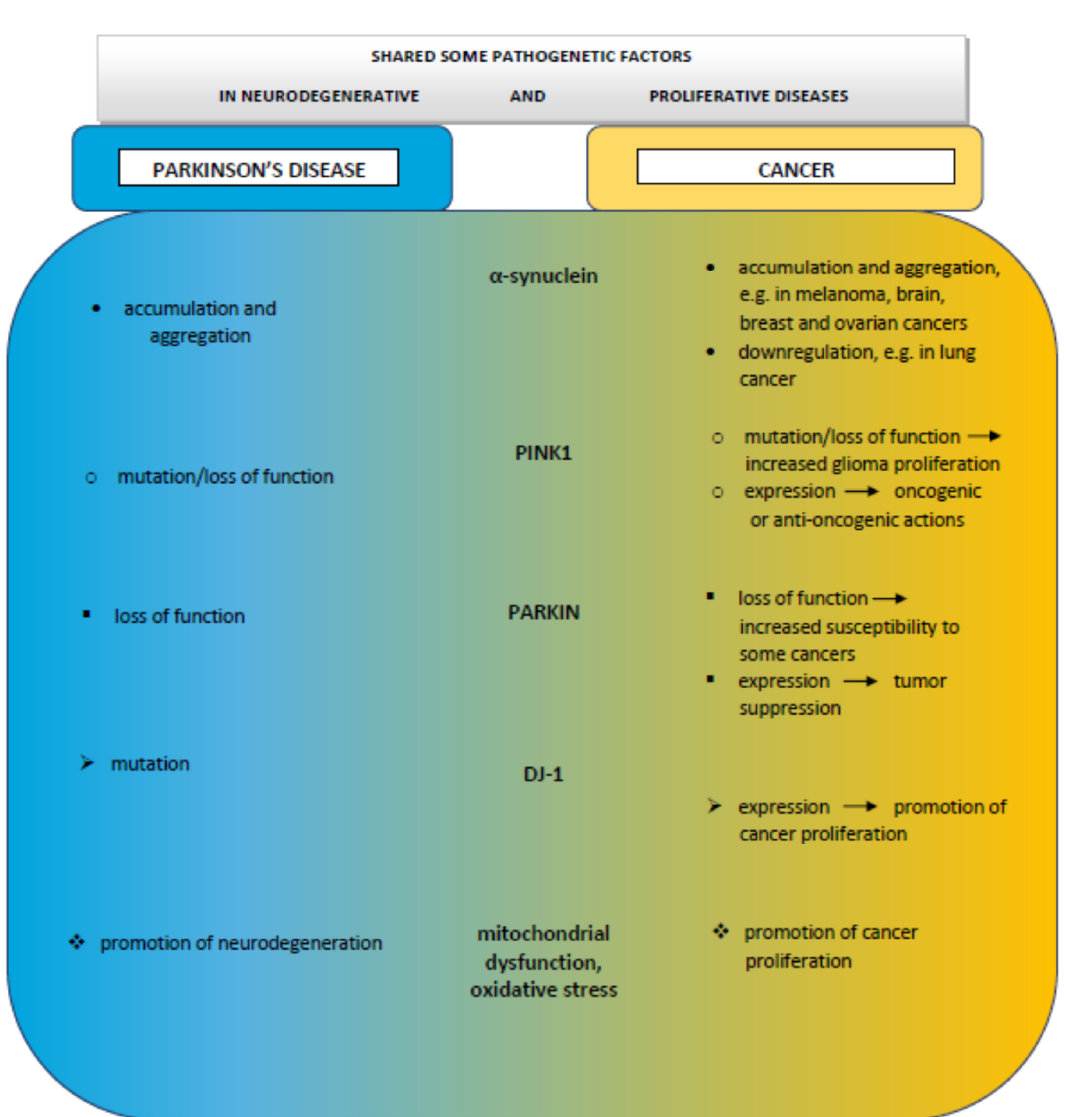
Figure 2. Schematic drawing of possible association between Parkinson’s disease and cancer.